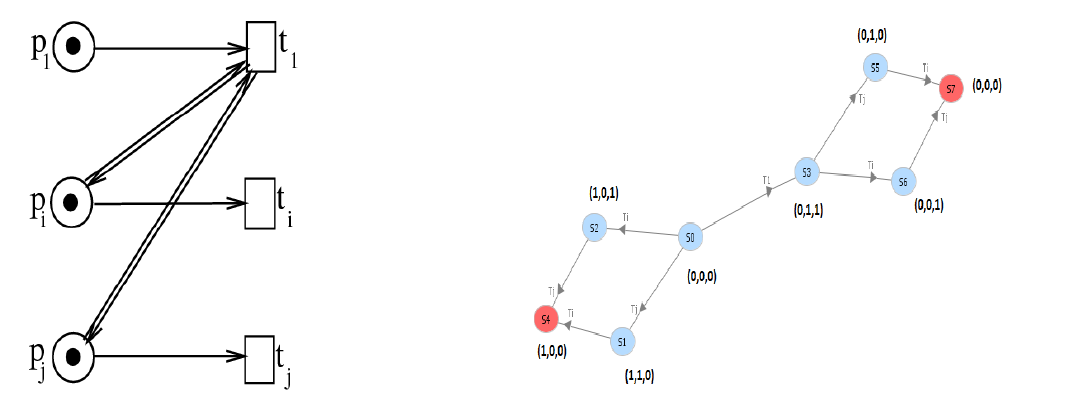
Figure 5. Petri net containing subnet-1 and its coverability